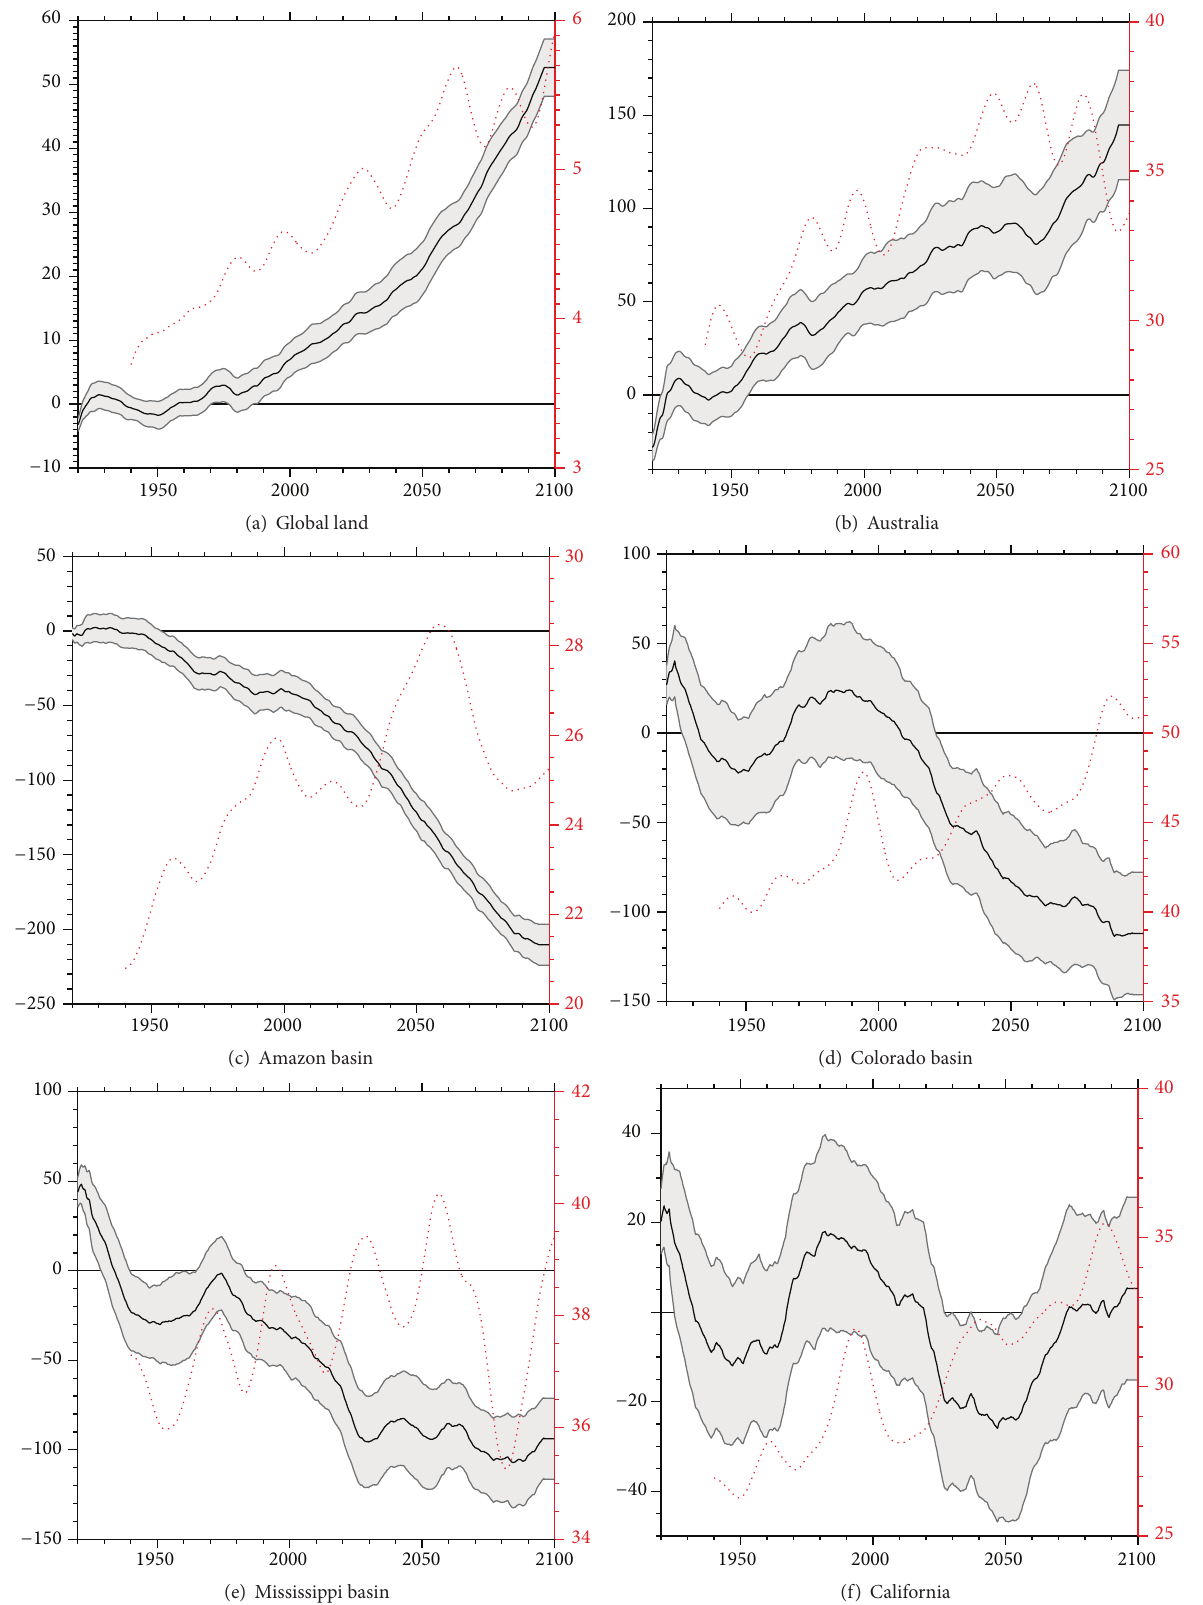
Figure 6: Time series of TWS anomalies and their interquartile range (shading) and internal variability based on the spread across ensemble members at each time (red dotted) for (a) global land, (b) Australia, (c) the Amazon, (d) Colorado, and (e) Mississippi river basins and (f) California. A 10-year running mean smoothing is applied to all time